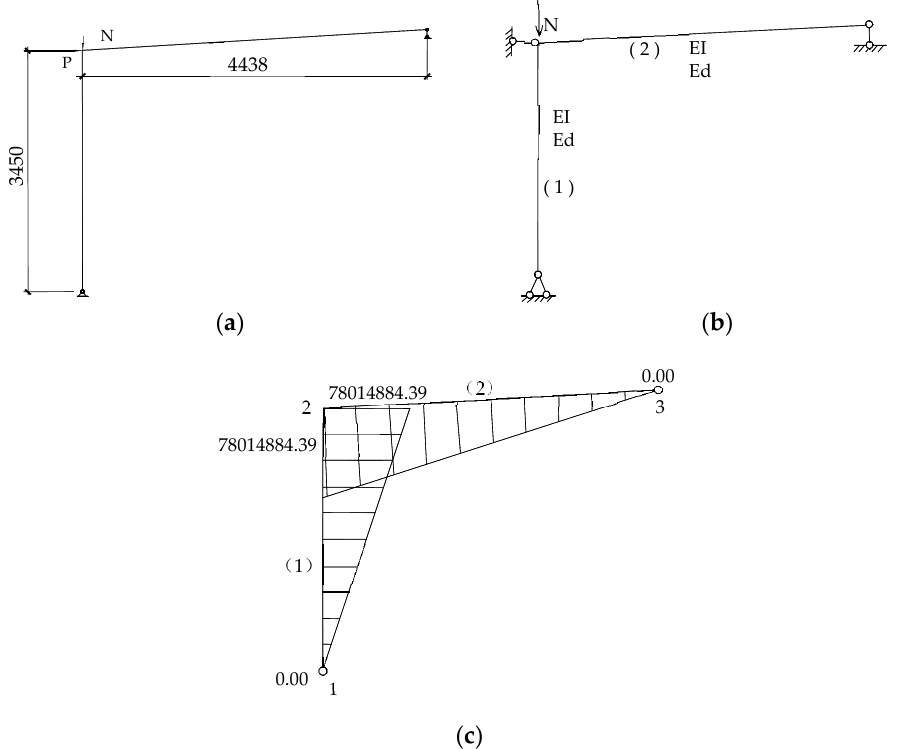
Figure 11. Envelope curves. ( a ) Specimen SV1 and SV3; ( b ) Specimen SV2 and SV3.